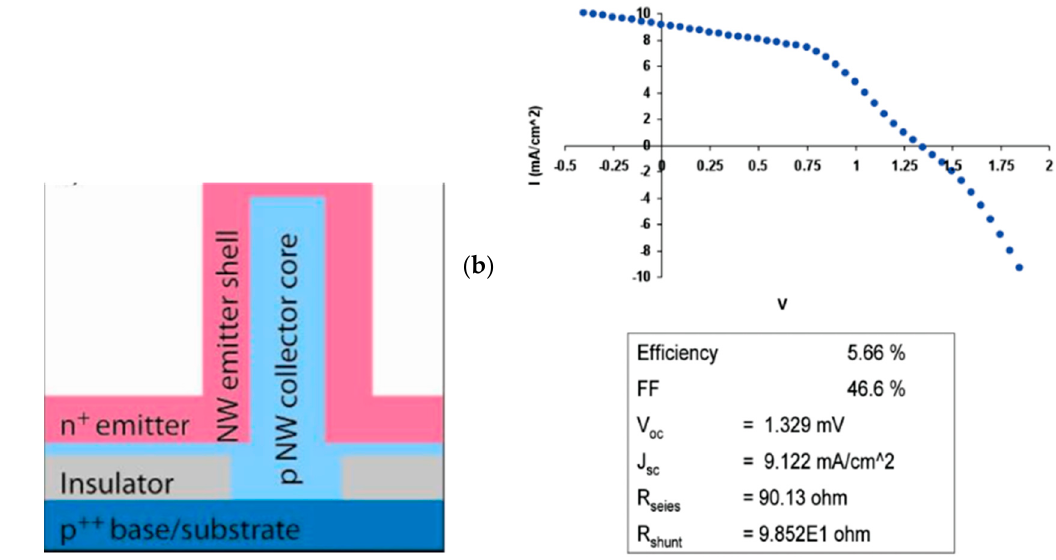
Figure 4. ( a ) Schematic illustration of p_n junction of Si-NWs, ( b ) I-V characteristics of the fabricated PV cell of Si-NWs.